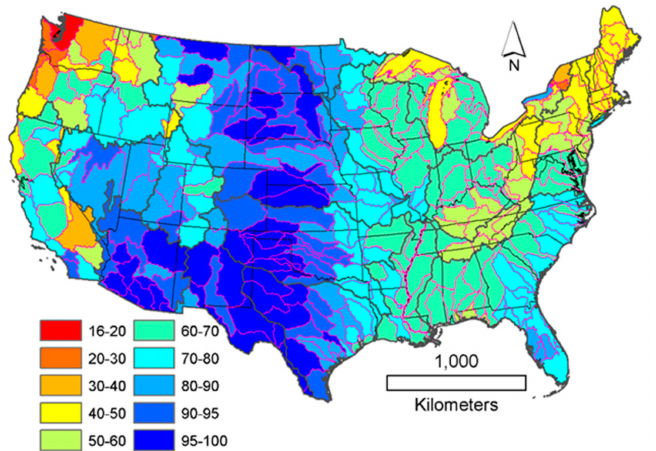
Figure 3. Spatial distribution of the ratio (%) of mean annual (1979–2015) HUC6-derived water-balance ET ( = P − Q ) and PRISM precipitation. The seven HUC6 basins with outlier streamflow rates (Figure 1) are left in the map for spatial continuity.